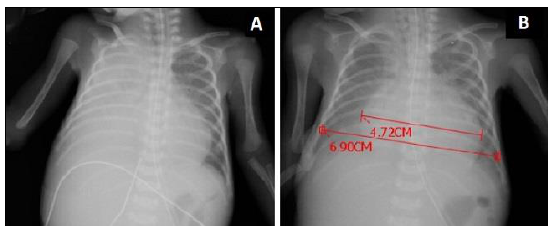
Figure 1: A. Chest radiograph shows right-sided pleural effusion. Note the catheter tip was in correct position. B. Chest radiograph after right thoracentesis. Catheter was removed. Lung fields were clear. Cardiothoracic index increased